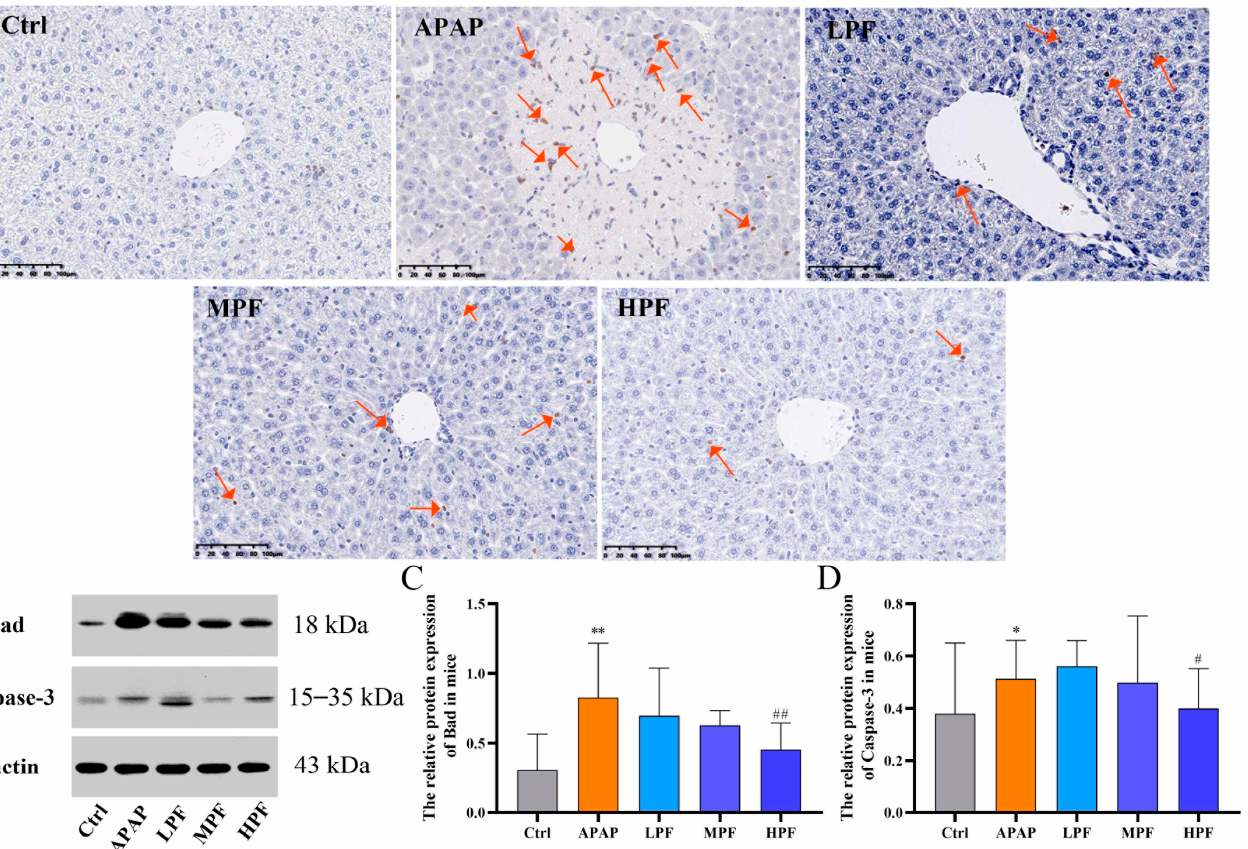
Figure 4. PF meliorated the damage of APAP through an anti-apoptotic effect. ( A ) The effects of PF on the apoptotic cell were verified by TUNEL staining. ( B ) Western blotting images of Bad and caspase-3 in mice. ( C ) The relative protein expression of Bad in mice. ( D ) The relative protein expression of caspase-3 in mice. All data were presented as mean ± SD. * p < 0.05, ** p < 0.01, compared with Control group; # p < 0.05, ## p < 0.01, compared with APAP group. The arrow points to areas of elevated apoptotic expression.